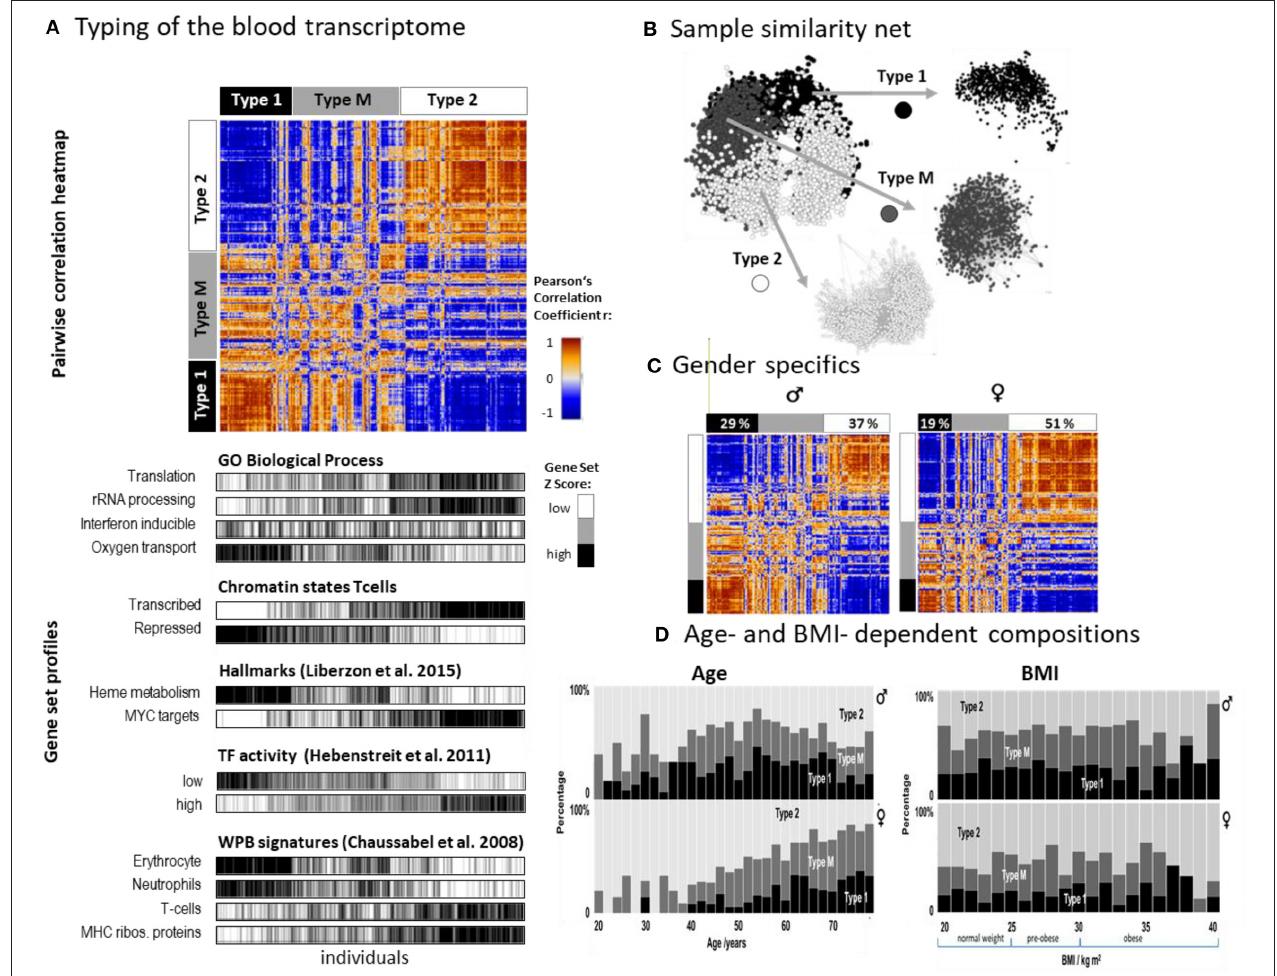
FIGURE 2 | Stratification of the blood transcriptome into three types: (A) The pairwise correlation heatmap divides the samples into three transcriptome types according to the mutual correlations between their SOM expression patterns. The part below associates the samples of all three types to selected functional categories by means of gene set overexpression. The samples are sorted into clusters according to different combinatorial pattern types (cPATs) which gives rise to the striped patterns in the map (see below). (B) Network presentation of the similarity relations illustrates that the samples of type 1 and type 2 form almost separate data clouds while type M overlaps with both. (C) Stratification of the samples into women and men shows essentially similar correlation heatmaps and thus similar expression patterns. Women however are more frequently found in type 2. (D) The composition of types changes with age in a gender specific way but does not with BMI (body mass index). The percentage of type 2 women permanently decreases with age while the relative amount of type 2 men older than 55 years again